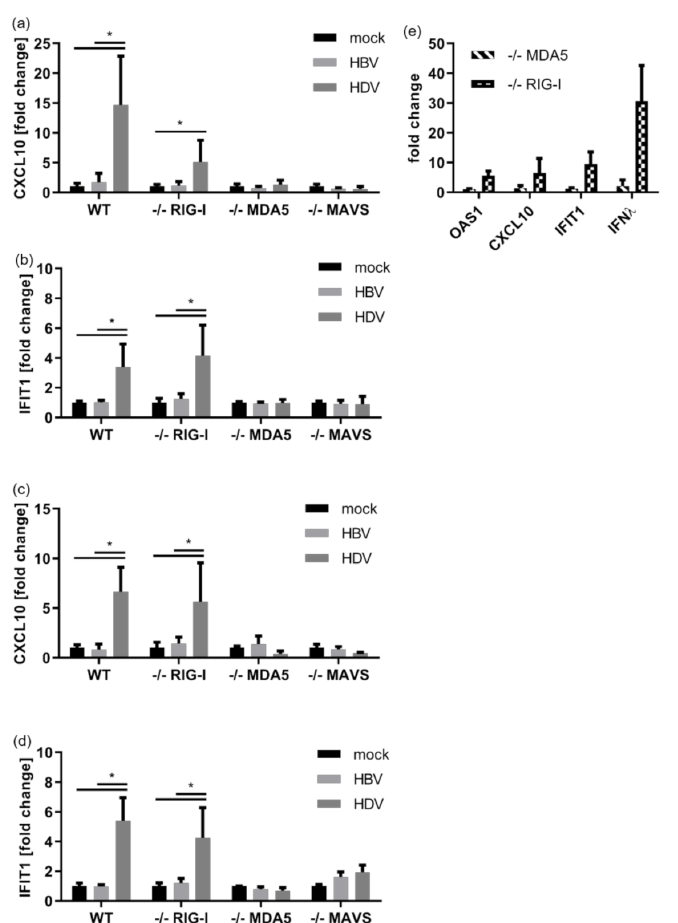
Figure 2. HDV is detected by MDA5. ( a – d ) HepG2-NTCP cells in which RIG-I, MDA5 or MAVS was knocked-out using CRIPSR/Cas9 were infected with HBV (light bars) or HDV (dark bars) at an MOI of 20 vp/cell each. RNA was extracted 7 ( a , b ) or 11 dpi ( c , d ) and subjected to qRT-PCR. Upregulation of ( a , c ) CXCL10 and ( b , d ) IFIT1 is given as fold induction relative to non-infected cells. Graphs depict a single experiment with biological quadruplicates. Data were analysed for normality distribution using Kolmogorov–Smirnov test, statistical analysis was done using Mann– Whitney-test. * p < 0.05 ( e ) MDA5-(striped bars) and Rig-I-knockout (plaid bars) HepG2-NTCP cells were transduced with AAV-HDV. RNA was extracted on day 11 dpi and subjected to qRT-PCR. Upregulation of the indicated ISGs and type III interferon λ (IFN λ ) is given as fold induction relative to non-infected cells. Graph depicts a single experiment with biological